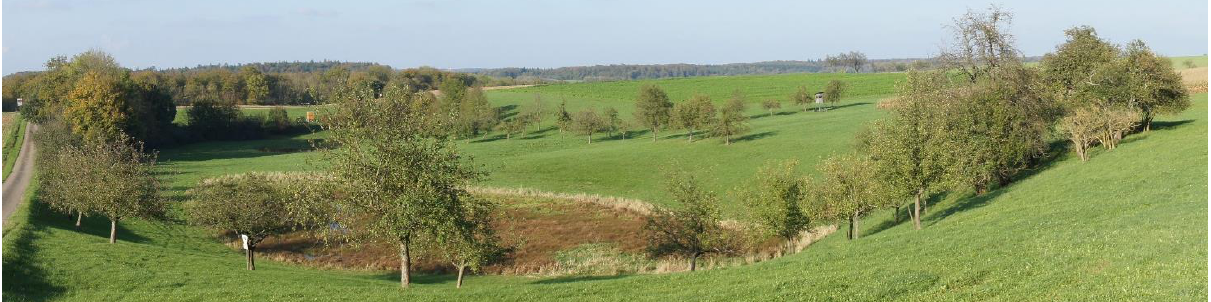
Figure 1. Karst depression ( Ottensee ) in the region of Hohenlohe, Baden-Württemberg. Picture captured from the south